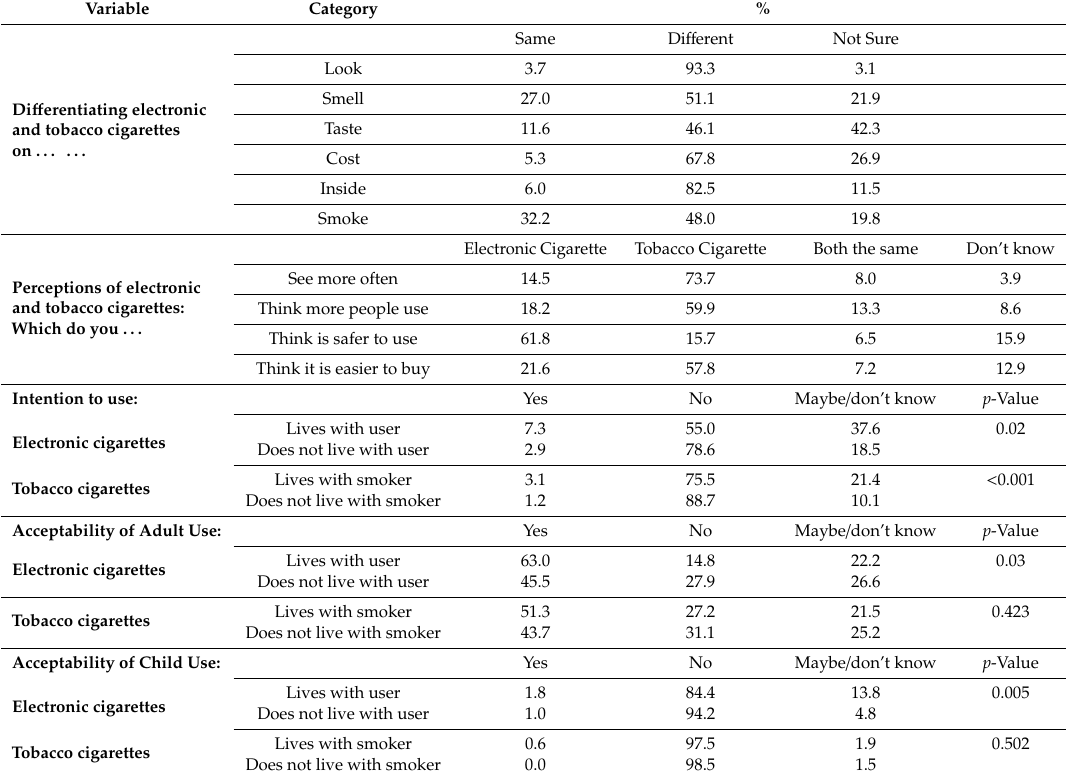
Di ff erentiating electronic and tobacco